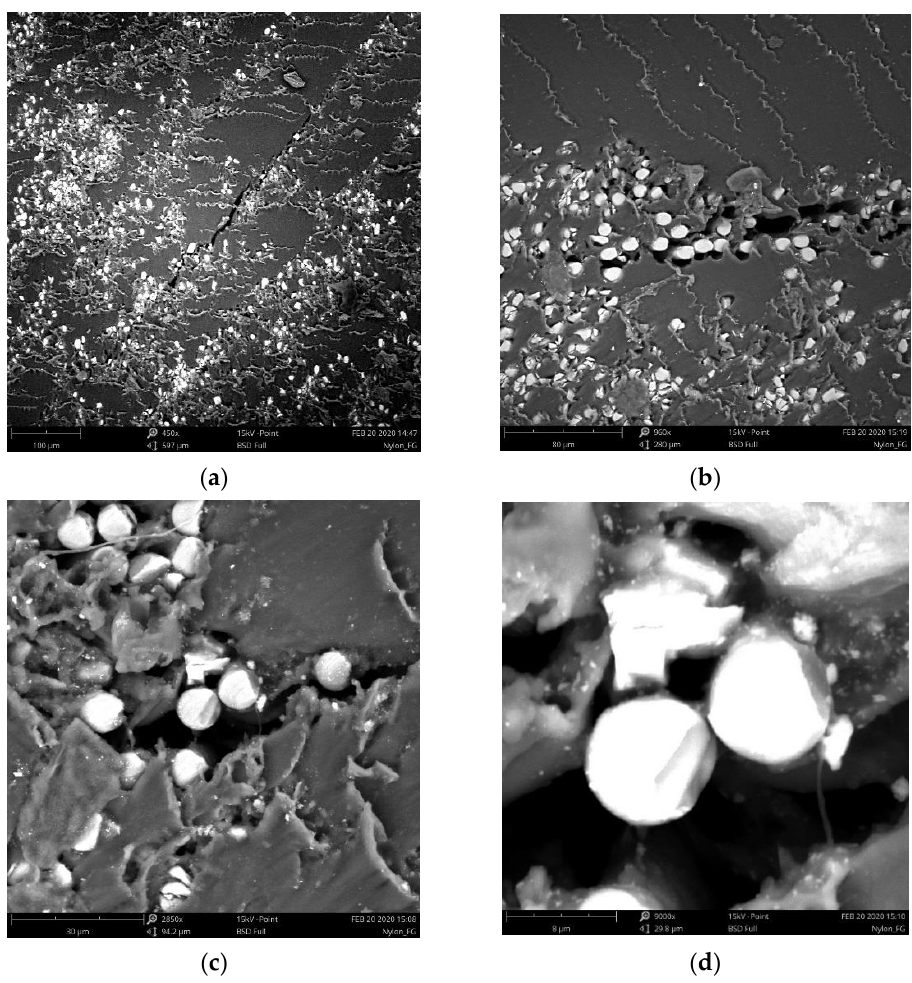
Figure 10. SEM images of the glass fiber distribution at different magnifications showing ( a ) interlaminar crack propagation between the 3D printed layers, ( b ) crack propagation on the interface of glass fibers and nylon matrix, ( c ) debonded glass fibers from the nylon matrix and ( d ) high magnification of the interfacially debonded fibers.